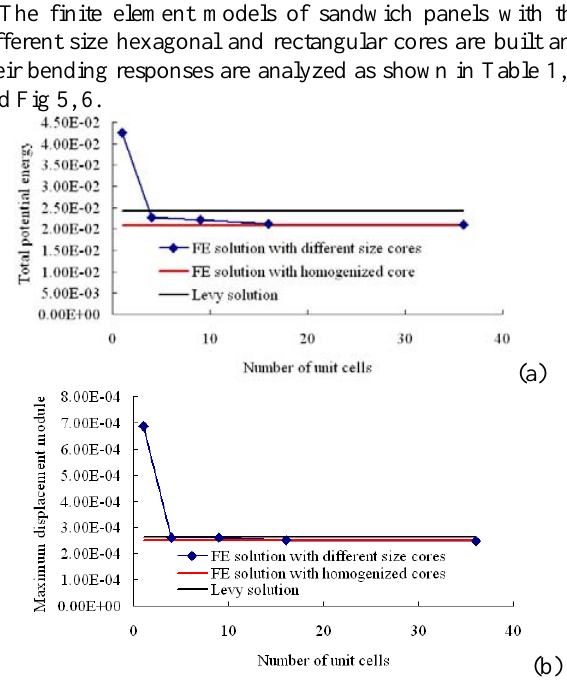
Fig.6. (a) Total potential energy and (b) Maximum dis- placement module of sandwich panel with the rectangular core